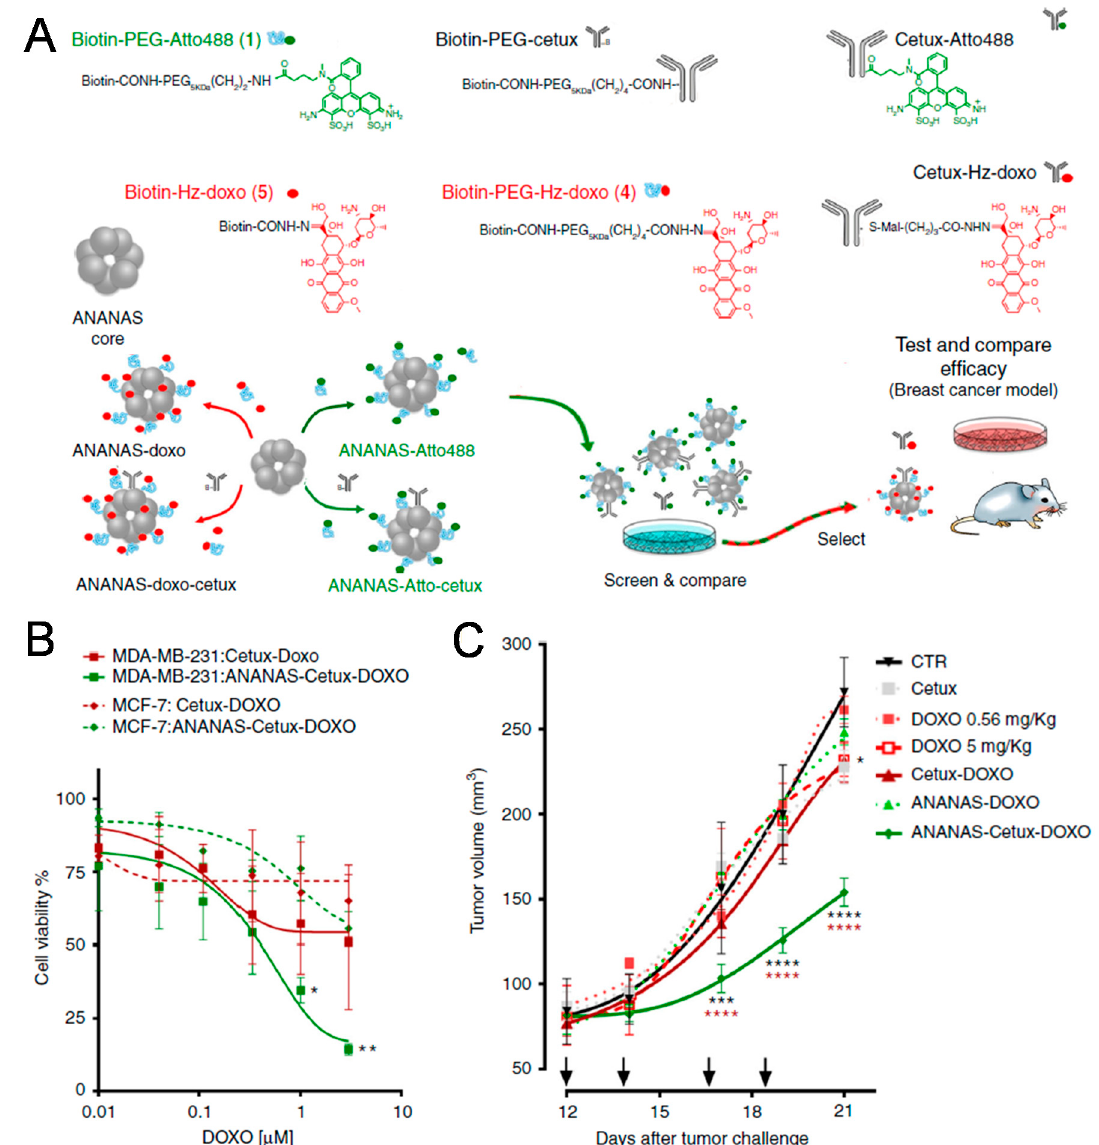
Figure 1. Antibody-conjugated nanoparticles (NPs). ( A ) Schematic illustration of antibody-guided avidin-nucleic-acid nanoassemblies (ANANAS) modified with antiepidermal growth factor receptor (EGFR) antibody (cetuximab) for enhancing cancer targeting. ( B ) Cell viability assay of cetuximab-guided ANANAS in MCF-7 and MDA-MB-231 cell lines. ( C ) Tumor growth in mice bearing MDA-MB-231 tumors after intravenous injection of cetuximab-guided ANANAS. Reproduced with permission from ref. 18.